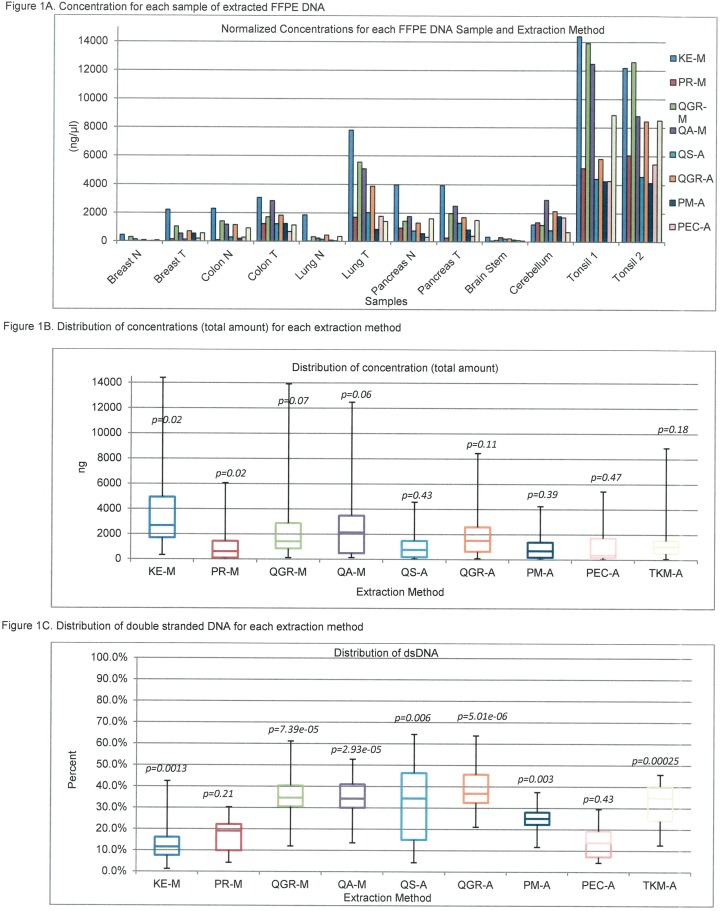
DNA quality metrics.Each extraction method is designated by a specific colour (see key) which is maintained in Fig 2A and 2B. A: Concentration for each sample of extracted FFPE DNA, B: Distribution of concentrations (total amount) for each extraction method, C: Distribution of double stranded DNA for each extraction method.